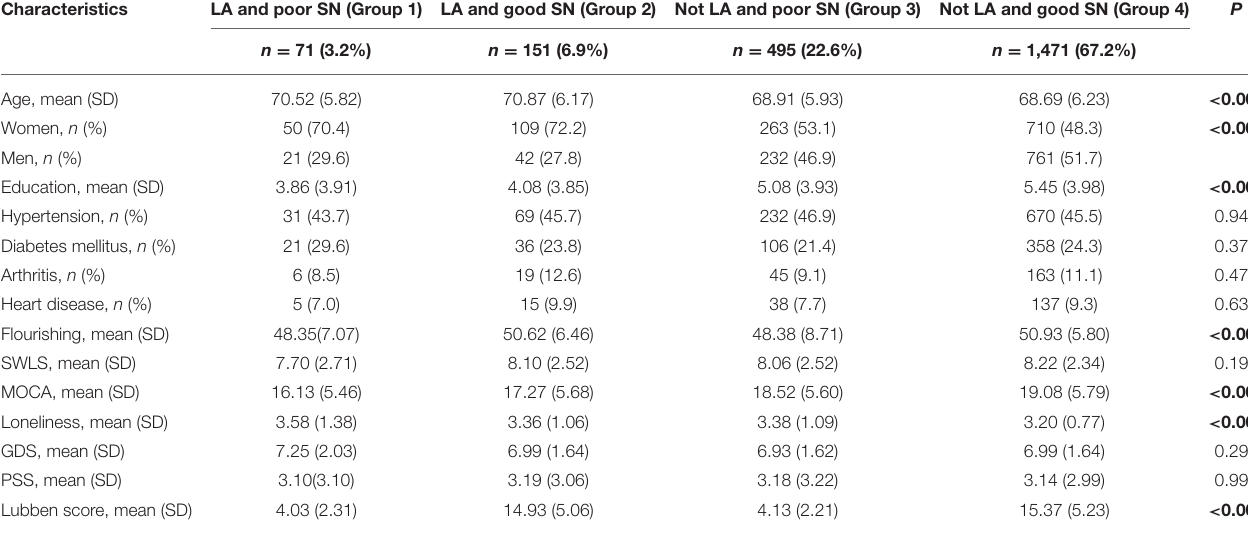
TABLE 1 | Characteristics of respondents stratified by the combination of living arrangement and quality of social network.